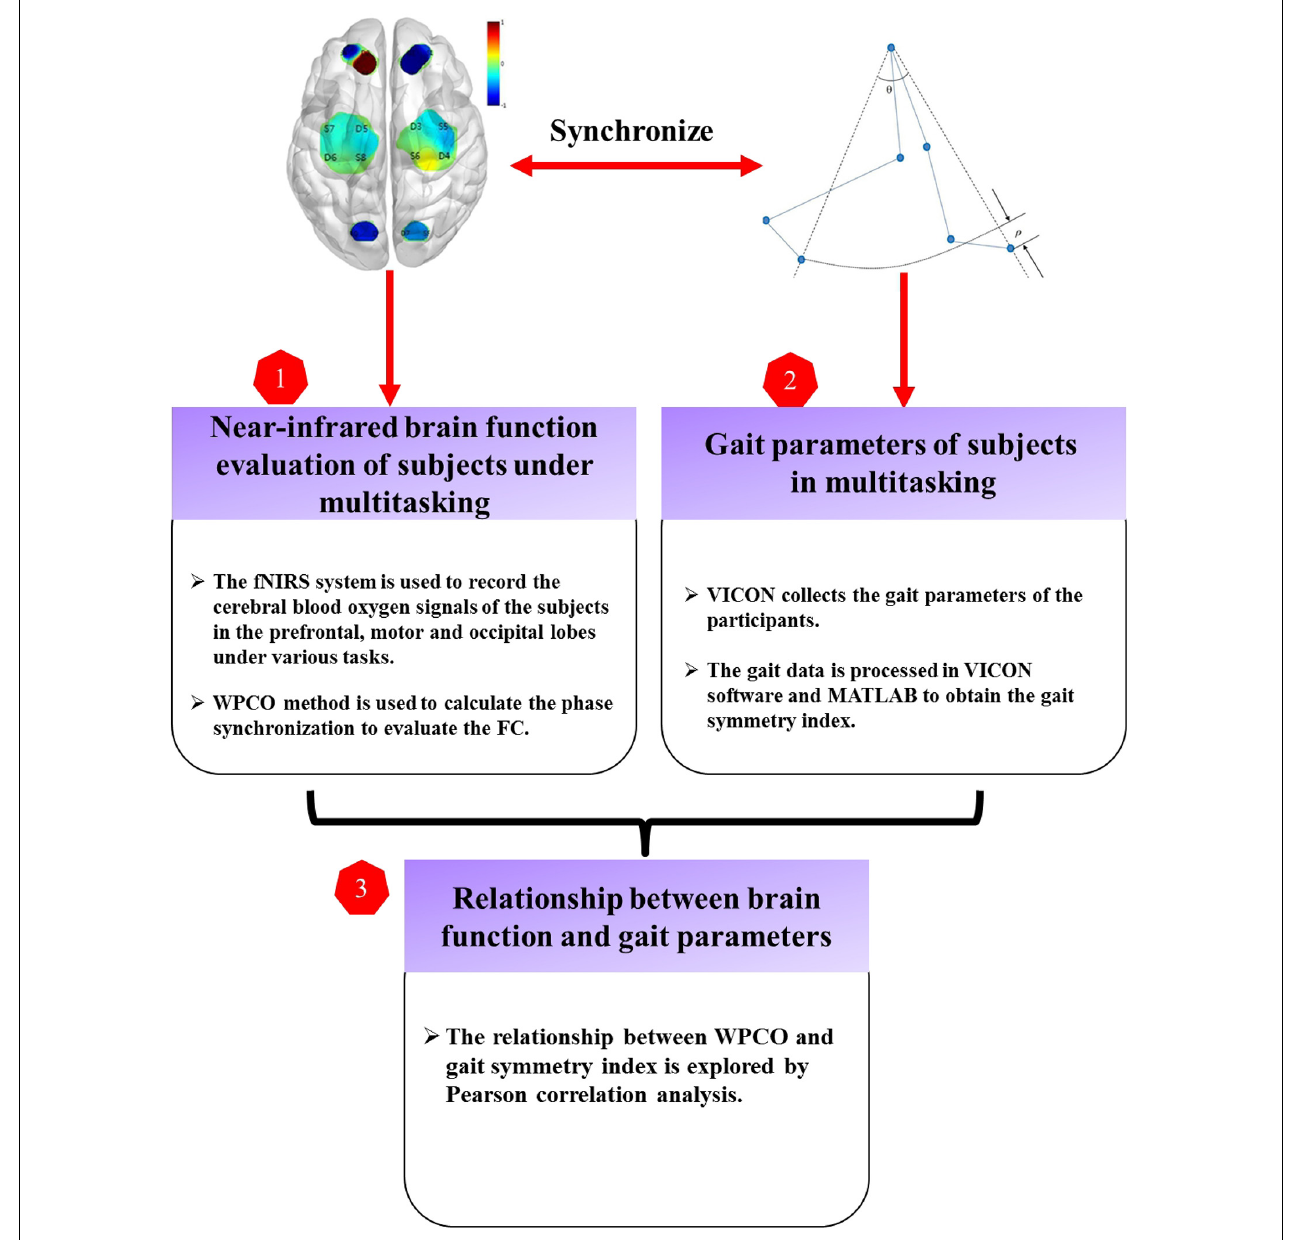
FIGURE 2 | Technology road map. FC, functional connectivity; fNIRS, functional near-infrared spectroscopy; WPCO, wavelet phase coherence.